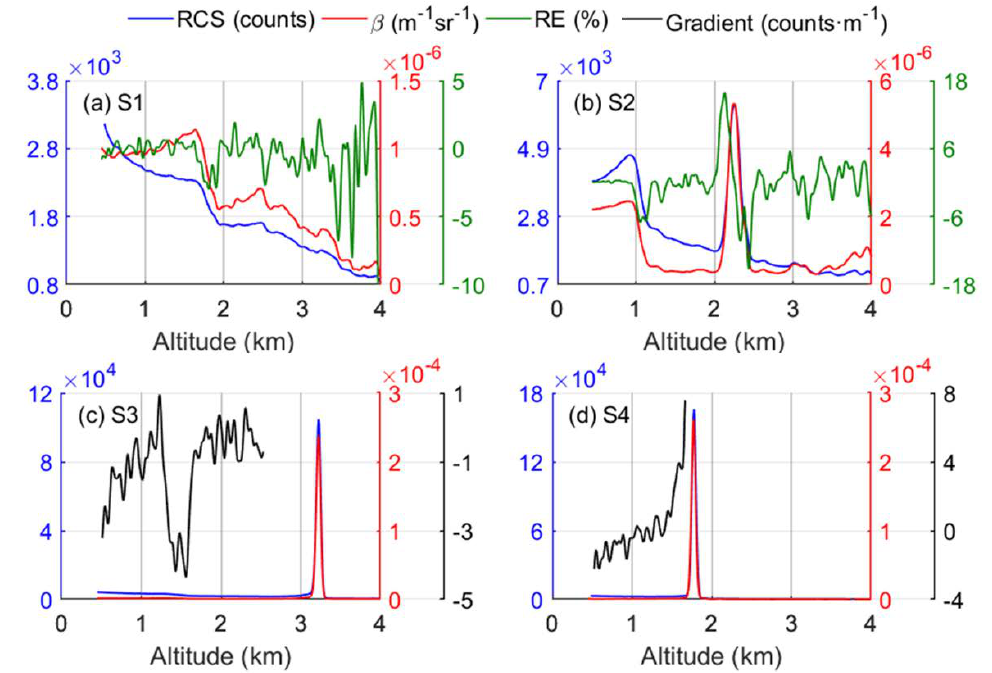
Figure 3. Vertical distributions of range-corrected signal (RCS) (blue line), backscatter coefficient ( β ) (red line), relative increase in backscatter coefficient (green line) and gradient of RCS with the lowest cloud base limiter (black line) on four typical situations: ( a ) single aerosol layer, observed at 17:30 LT, 21 August 2017 over the Southern Great Plains (SGP) site; ( b ) lofted aerosol layer, observed at 05:50 LT, 20 February 2018 over the Seoul site; ( c ) cloud layer outside the planetary boundary layer (PBL) is observed at 11:50 LT, 5 August 2018 over the SGP site and ( d ) cloud layer within the PBL is observed at 11:30 LT, 29 August 2018 over the SGP site.